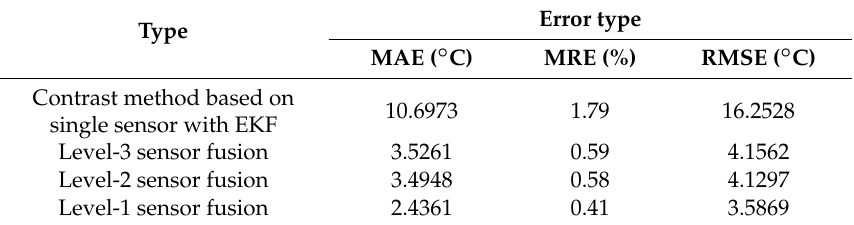
Table 1. Mean absolute error (MAE), mean relative error (MRE), and root mean square error (RMSE) of the contrast method and level-three, level-two, and level-one sensor fusion for the simulation case.